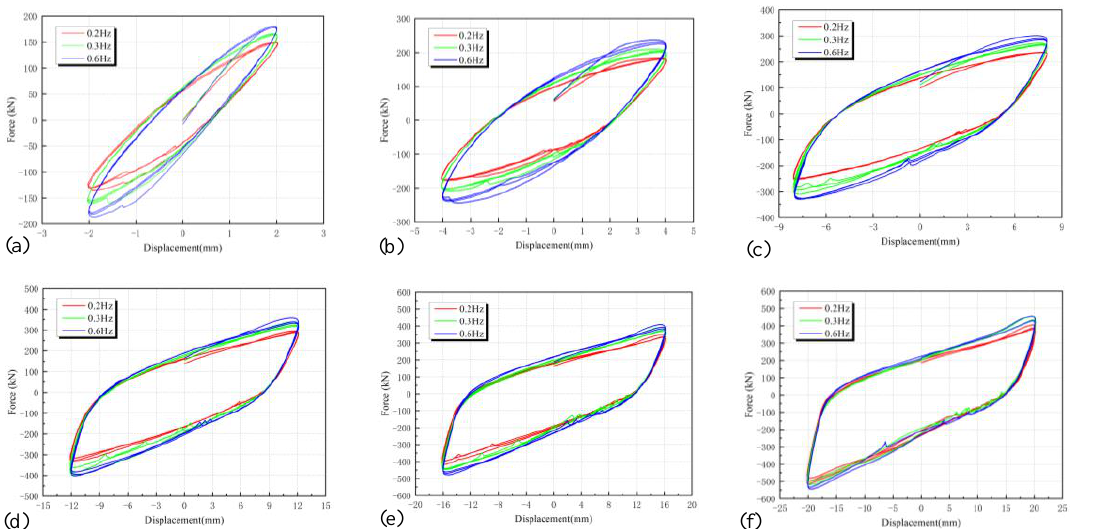
Figure 5. Hysteresis curves of VBRB (frequency dependency): ( a ) γ = 20%, ε = 0.24%; ( b ) γ = 40%, ε = 0.48%; ( c ) γ = 80%, ε = 0.95%; ( d ) γ = 120%, ε = 1.43%; ( e ) γ = 160%, ε = 1.91%; and ( f ) γ = 200%, ε = 2.38%.